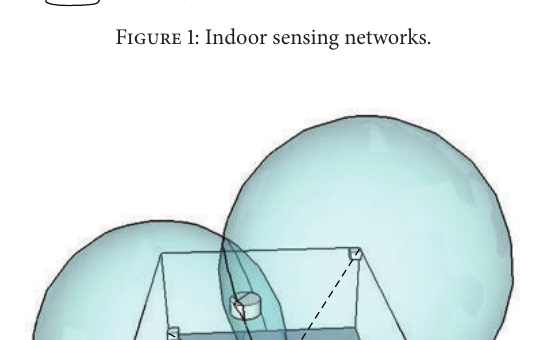
Figure 1: Indoor sensing networks.